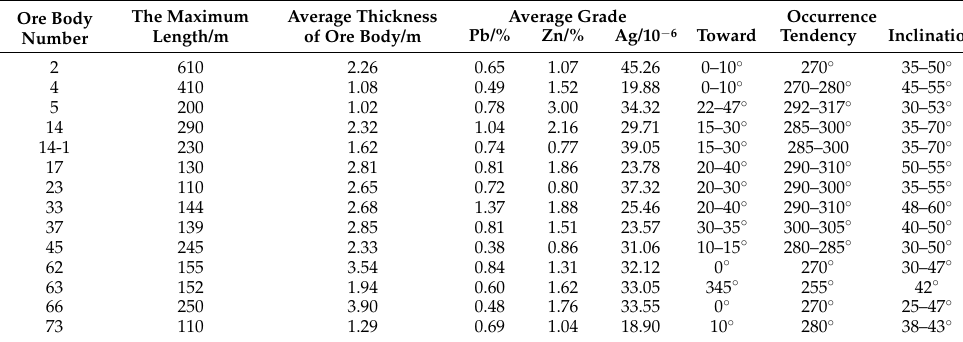
Table 1. Detailed characteristics of Jilinbaolige ore bodies.